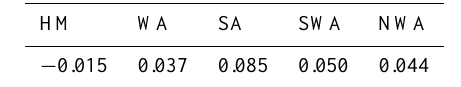
Table 6. The linear trends for GWLs with the highest E c for dry days in Crkvice and Herceg Novi.